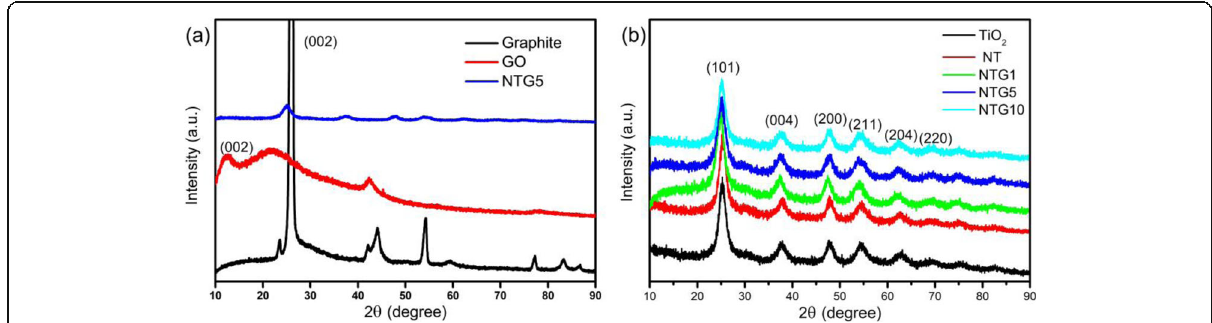
Fig. 2 XRD patterns of Graphite, GO and NTG